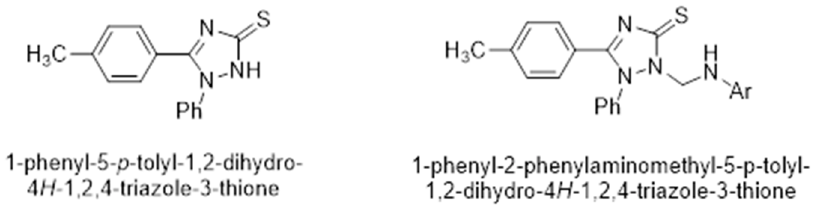
Table 1. Calculated NMR chemical shifts in ppm with TMS (for H and C atoms) and NH3 standards (for N atoms) by the GIAO method at the B3LYP/6 ‐ 31+G (d, p) level of theory and experimentally determined.